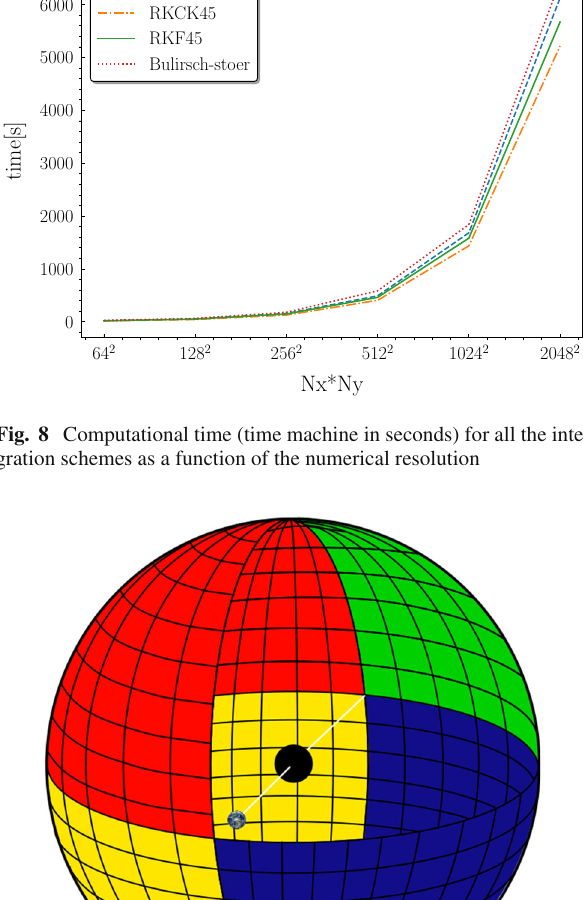
ors: blue, green, yellow, and red. Furthermore, the notion of curvature is provided by a black mesh with constant